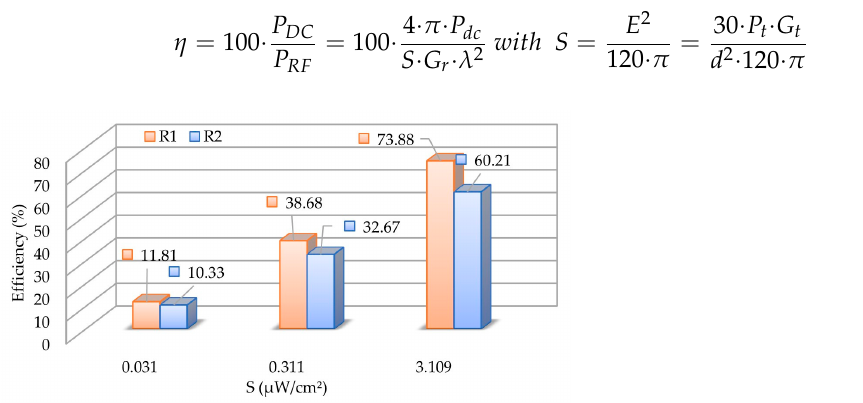
Figure 13. RF-DC conversion efficiency for the rectennas at 868 MHz for various decade power densities.